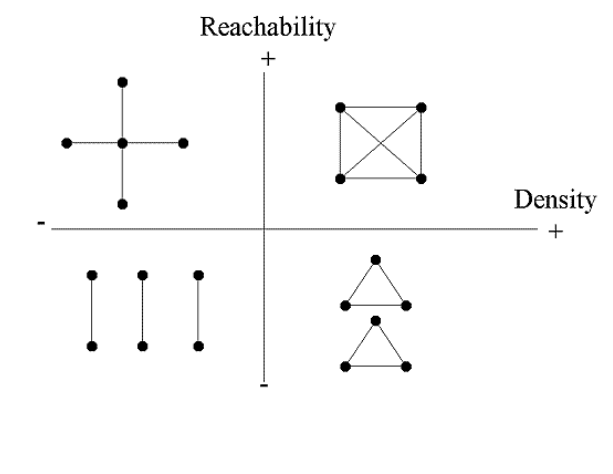
Fig. 1 . Different types of networks as a function of reachability and